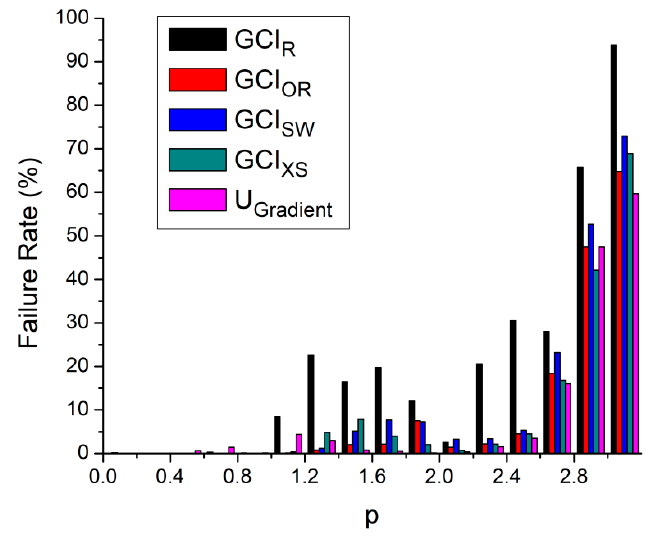
Figure 3. Failure rate of each method, based on the value of p .